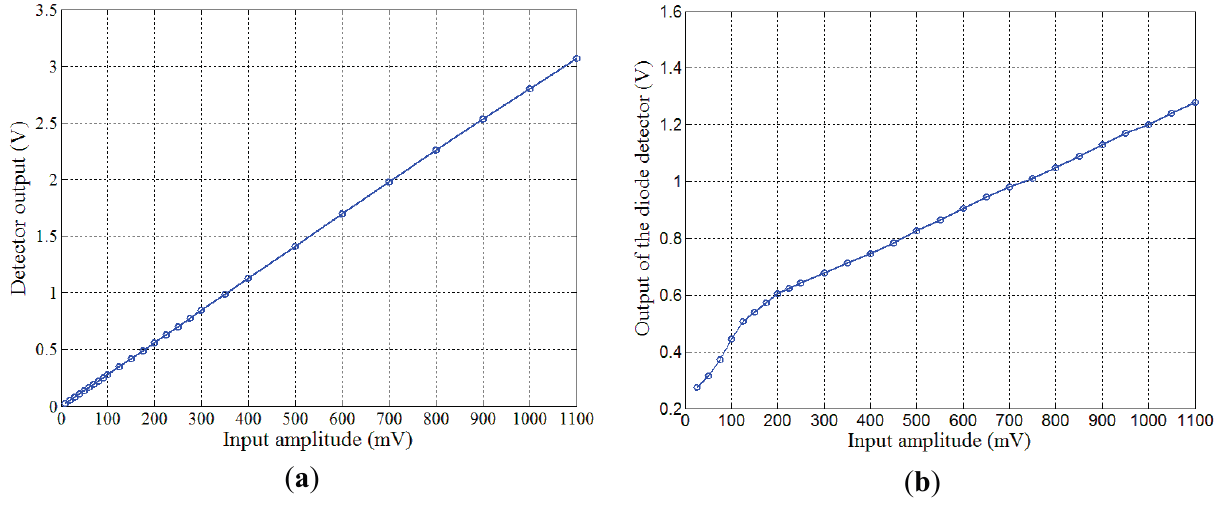
Figure 10. Comparison between the linearity of ( a ) the developed detector and ( b ) a commercial diode-based peak detector (LTC5507).